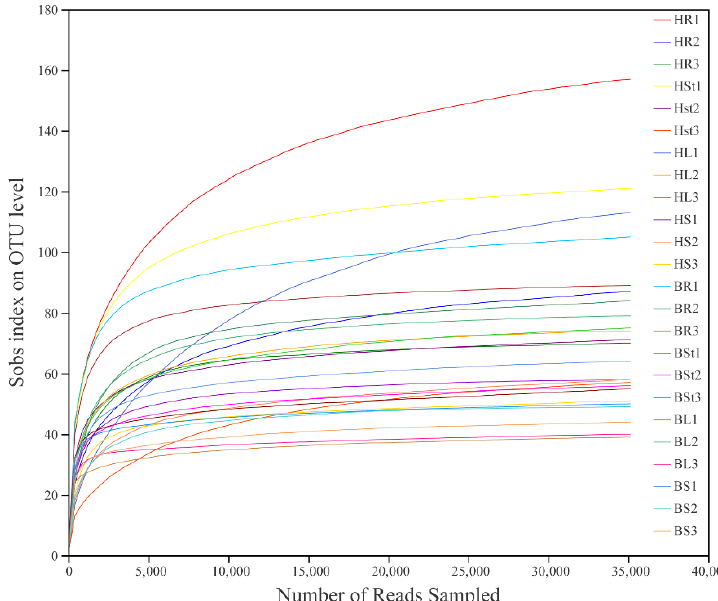
Figure 1. Rarefaction curve of endophytic fungi in 24 S. alopecuroides samples based on sobs in- dex. Note: the abscissa represents the amount of randomly selected sequencing data; the ordinate represents the number of species